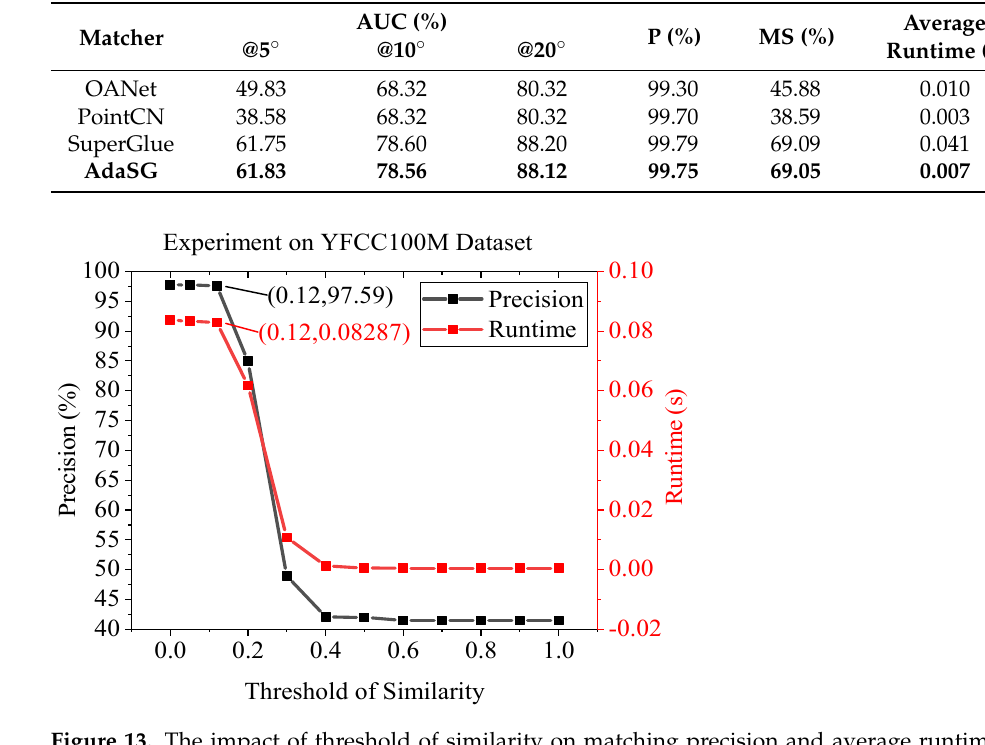
Figure 14. The impact of threshold of similarity on matching precision and average runtime on KITTI dataset. 4.4. Experimental Results on Embedded System Figures 15 and 16 show the experimental results on the embedded system RK3399Pro for the KITTI dataset. As can be seen from the Figure 16, the matching performance of the AdaSG is similar to that of the SuperGlue on different sequences. Figure 15 shows the runtime comparison of the AdaSG and the SuperGlue. It can be seen that the average runtime of AdaSG is around 10× less than SuperGlue on the sequences 01, 03, 04, 06, 09, and 10, and is around 3× less than SuperGlue on the sequence 00, 02, 05, 07, and 08. Com- pared with the SuperGlue, the proposed AdaSG is much faster when running on resource- constrained devices.